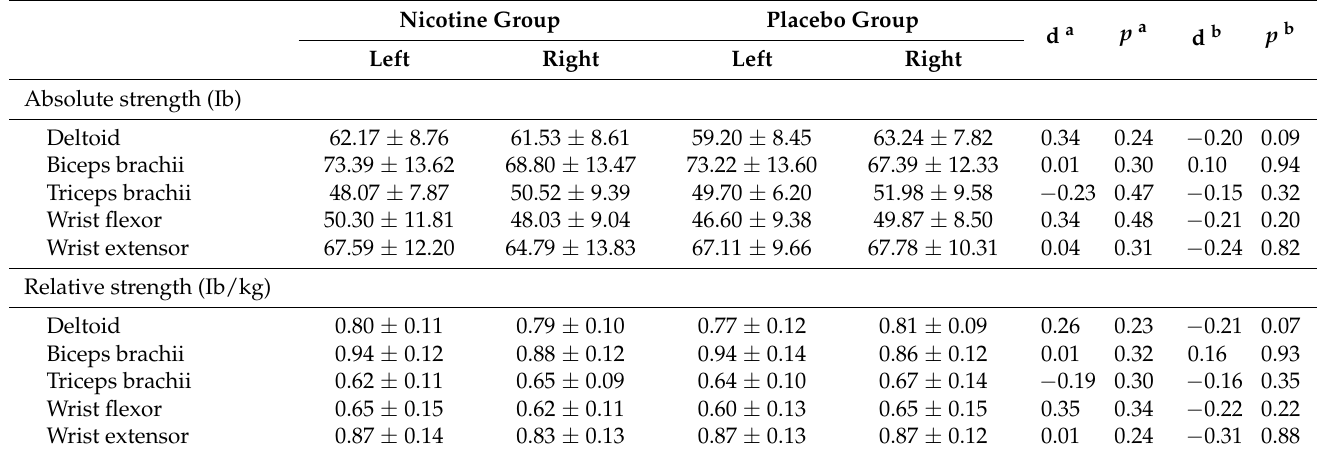
Table 4. Absolute and relative muscle strengths in both groups.